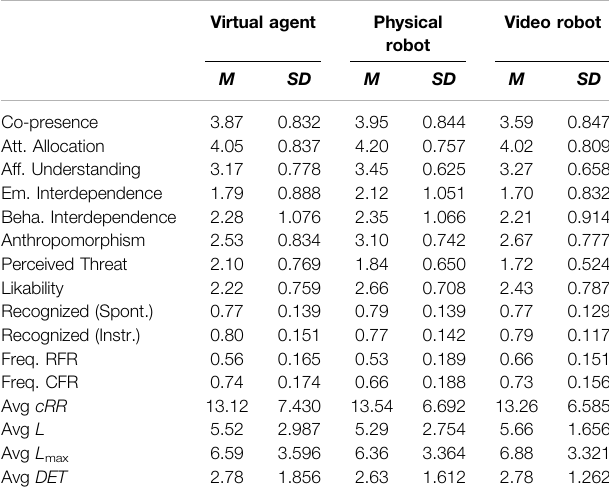
TABLE 3 | Descriptive Statistics of the 3 x 3 Mixed Measures ANOVAs per Embodiment: Mean ( M ) and standard deviation ( SD ) of all dependent